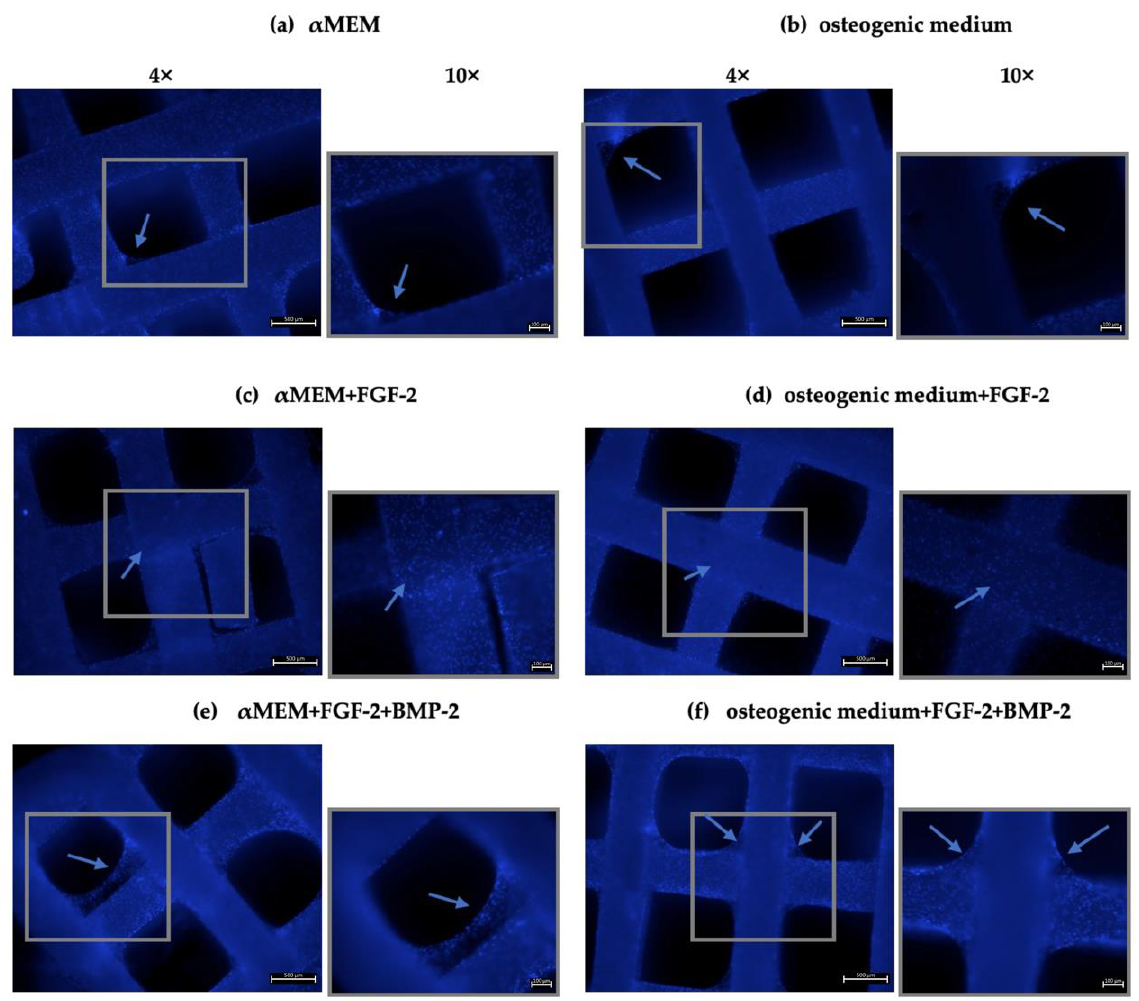
Figure 4. Ovine BM-MSC nuclei stained with DAPI (blue) on an nHAP-coated PCL/HAP/ β -TCP scaffolds 21 days after seeding, cultured in ( a ) α MEM, ( b ) osteogenic medium, ( c ) α MEM + FGF-2, ( d ) osteogenic medium + FGF-2, ( e ) α MEM + FGF-2 + BMP-2 and ( f ) osteogenic medium + FGF-2 + BMP-2. The BM-MSCs maintained good material affinity on the scaffold, as indicated by the number of nuclei on the cross-bar segments of the scaffold. However, stimulation with FGF-2 and BMP-2 increased cell proliferation not only on the scaffold bars but also in the space between the bars. A higher magnification (10 × ) was added next to each picture in order to show the area marked with the gray